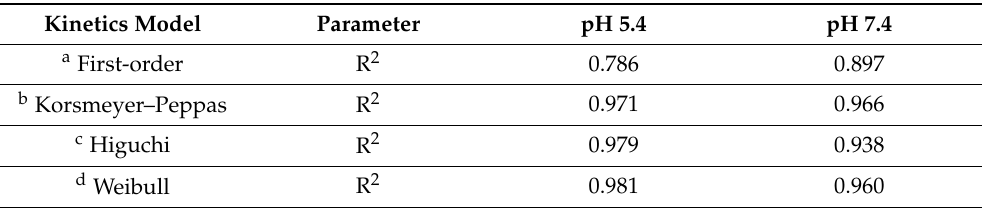
Table 1. Kinetics models for DOX release from MNP-F127-3-DOX nanocomposites at different pH values at 37 ◦ C.